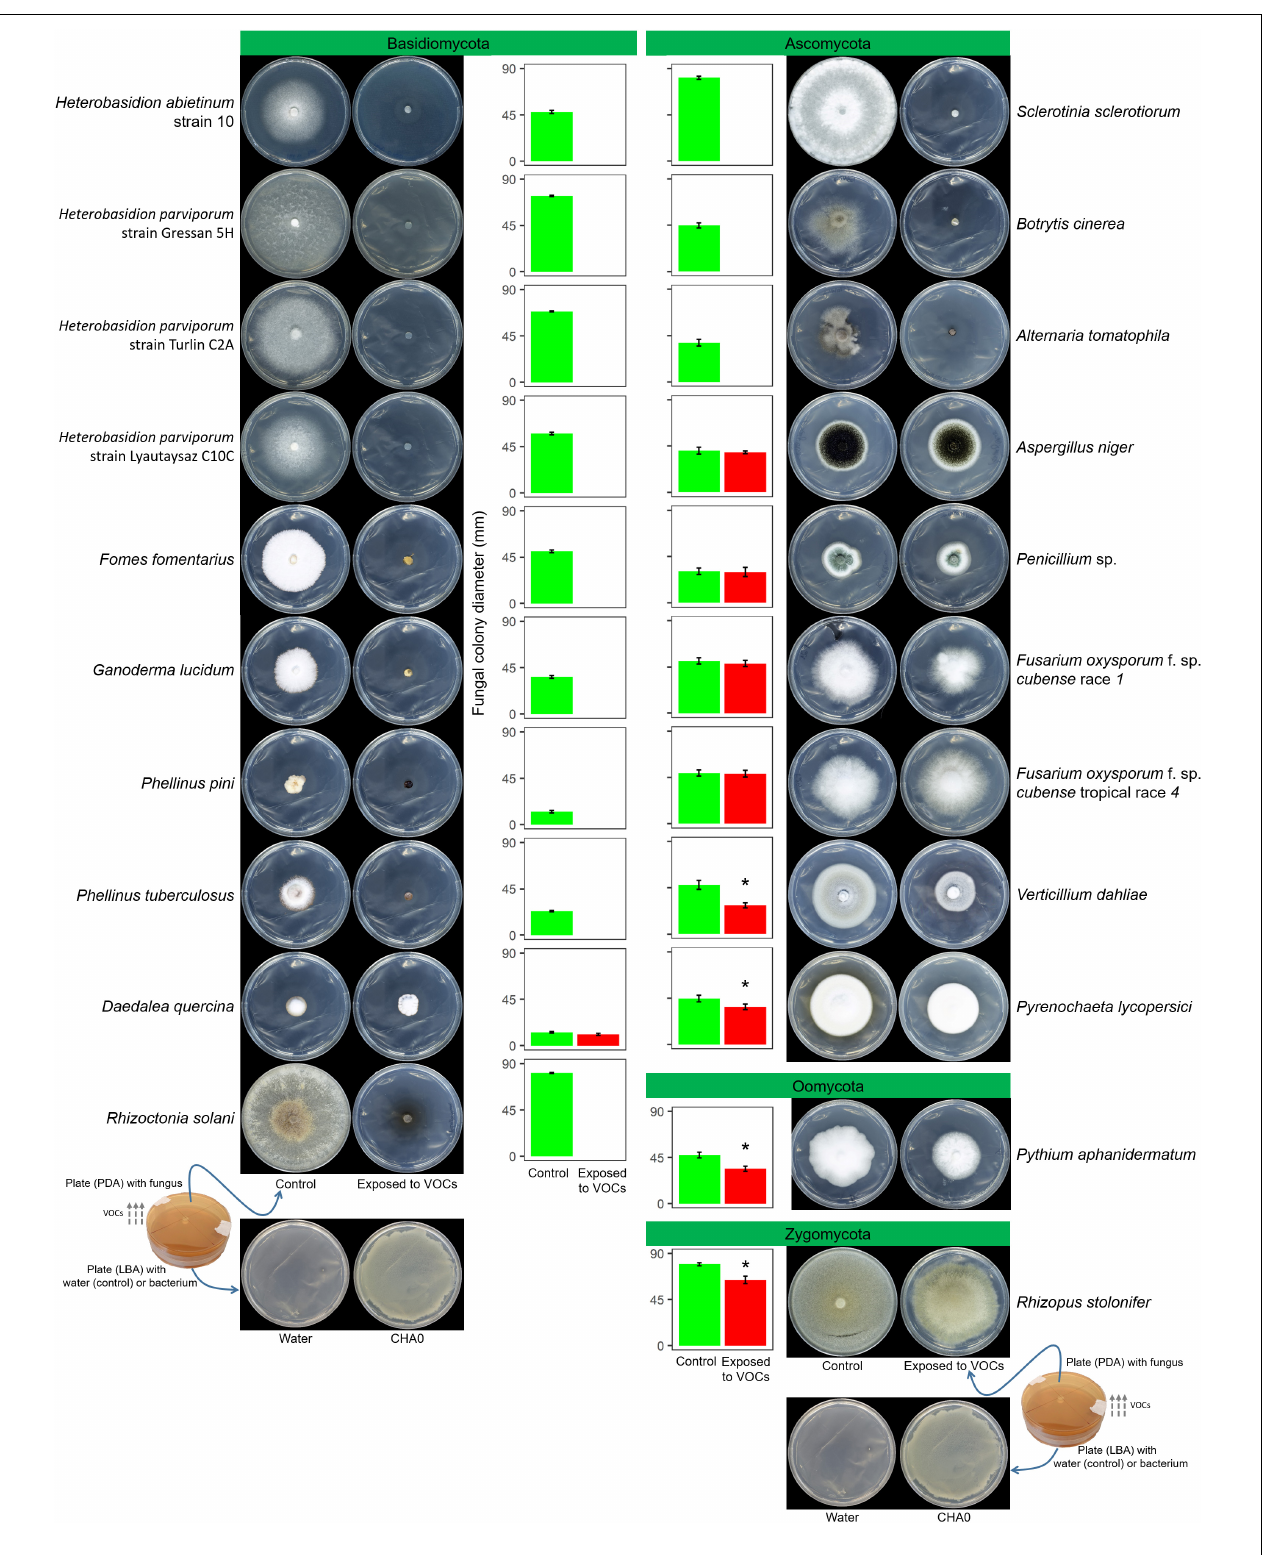
FIGURE 1 | Experiment A . Effects of volatile organic compounds (VOCs) emitted by Pseudomonas protegens CHA0 against several plant pathogens in the overlapping plate assay. Photos were taken 7 days after the plates were joined and sealed, i.e., 7 days of exposure to CHA0’s VOCs. In the graph, error bars are the standard error of the mean of three replicates (plates). Bars with the asterisk are significantly different from the control according to the LSD test ( P < 0.05).